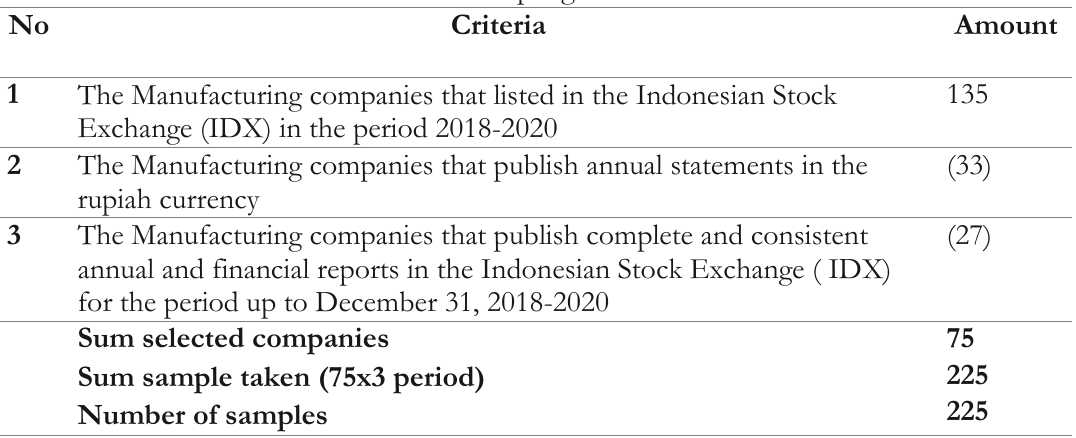
Table 2. Sampling Procedure